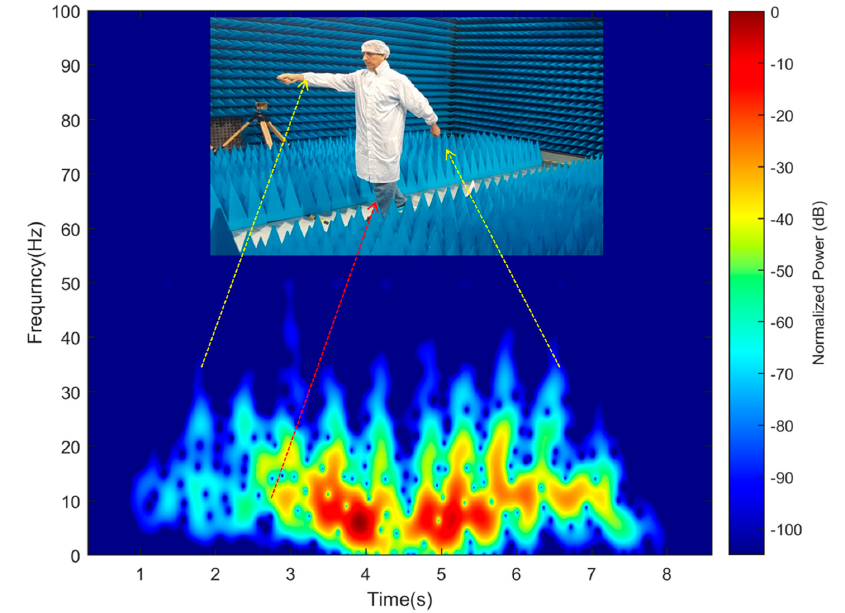
Figure 24. Spectrogram of Doppler signature for man normally walking and swinging two hands.